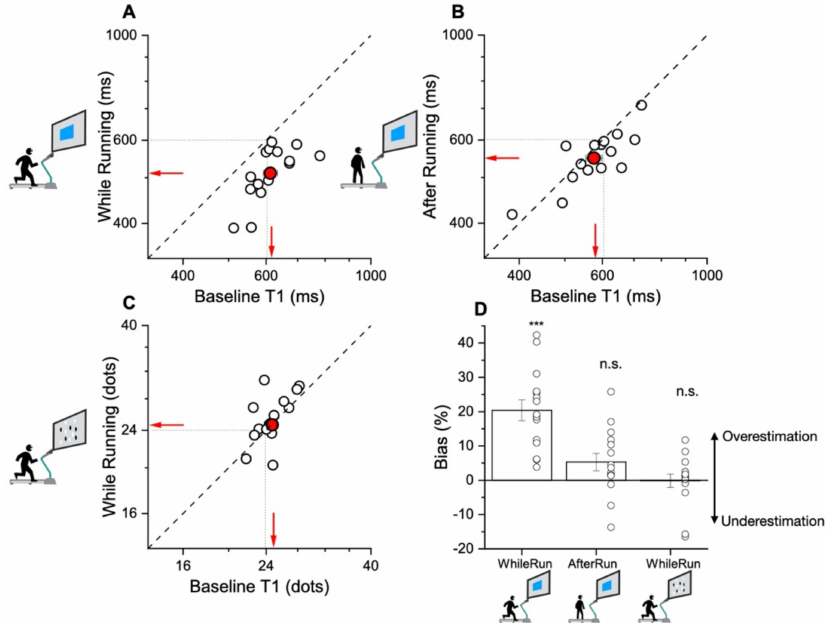
Figure 5. Individual data and perceptual biases magnitudes. Scatter plots showing PSE (log units) separately calculated for each participant (open symbols). Filled symbols refer to group averages. Symbols falling below the equality line (dashed line) reflect lower PSEs in the running condition, hence an overestimation of duration or numerosity. ( A ) Duration PSEs during running against first baseline (T1). ( B ) Duration PSEs after running against first baseline (T1). ( C ) Numerosity PSEs during running against first baseline (T1). ( D ) Bar plot showing estimation biases relative to the baseline condition (T1), normalized by the reference stimulus (600 ms or 24 dots). Bars represent the three experiments: duration while running, duration after running, and numerosity while running, respectively. Bars are between participant’s average, error bars are ± 1 SEM. Individual data are represented by symbols. *** p < 0.001 n.s. not